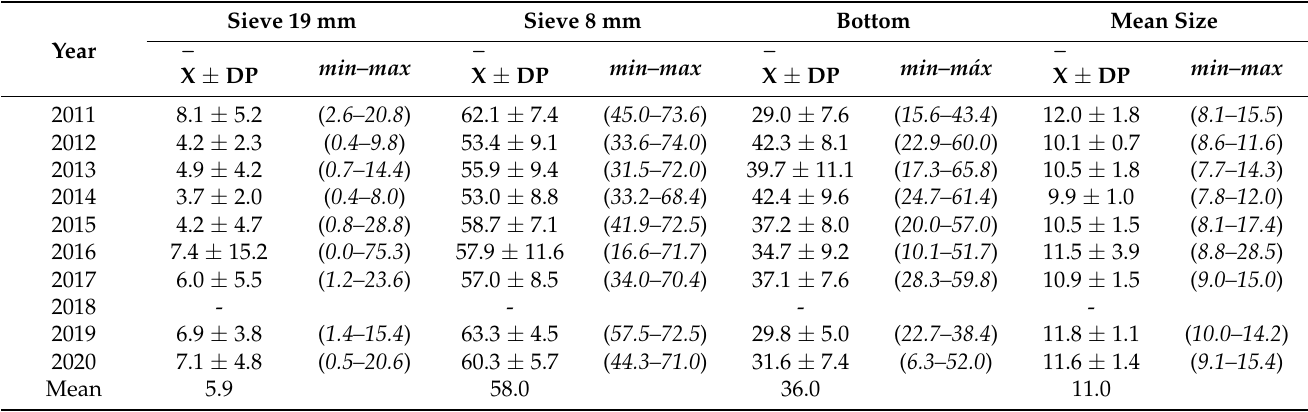
Table 7. Particle separation (%) by Penn State sieve and mean particle size (mean ± SD/min–max)